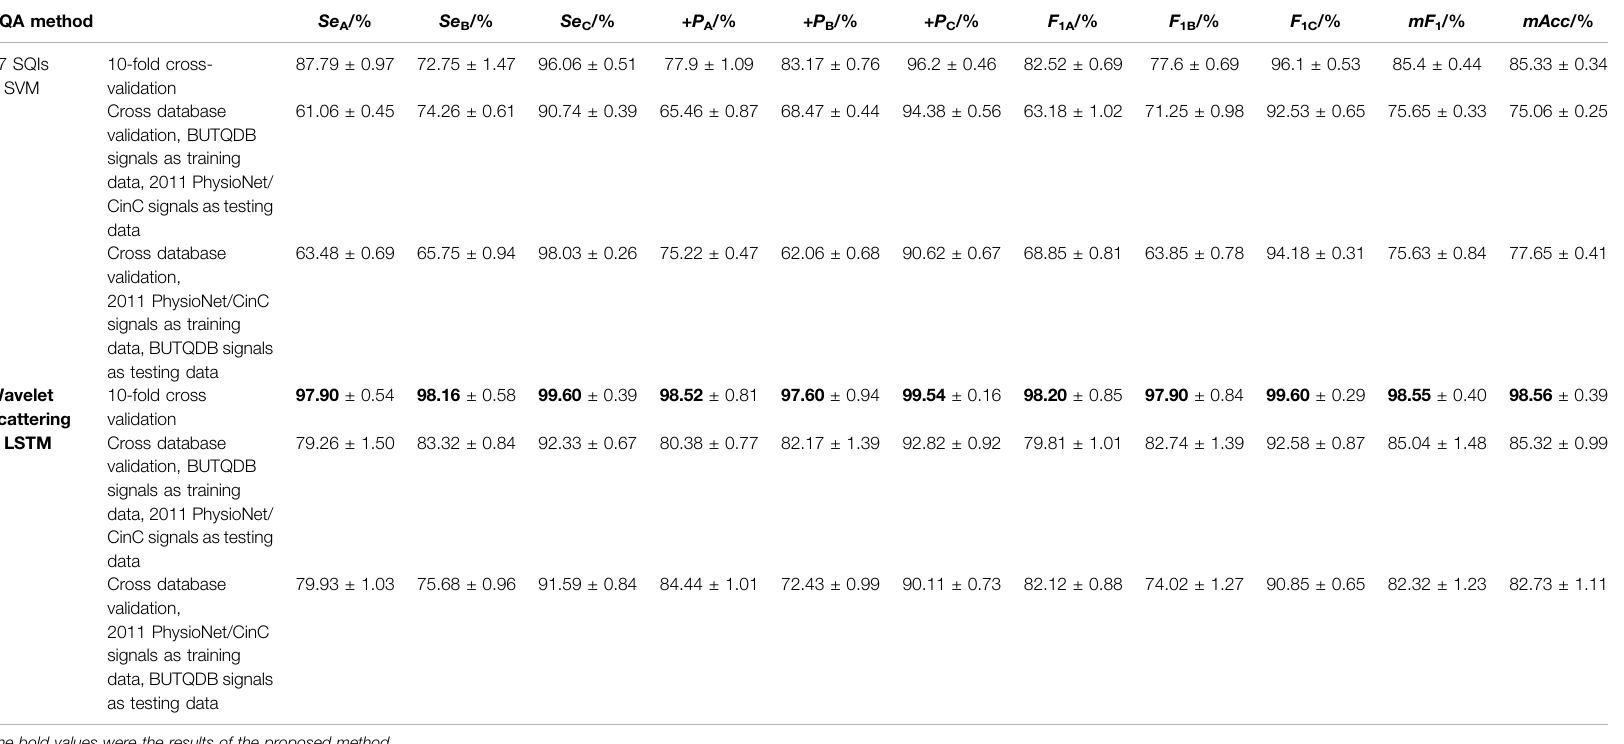
The bold values were the results of the proposed